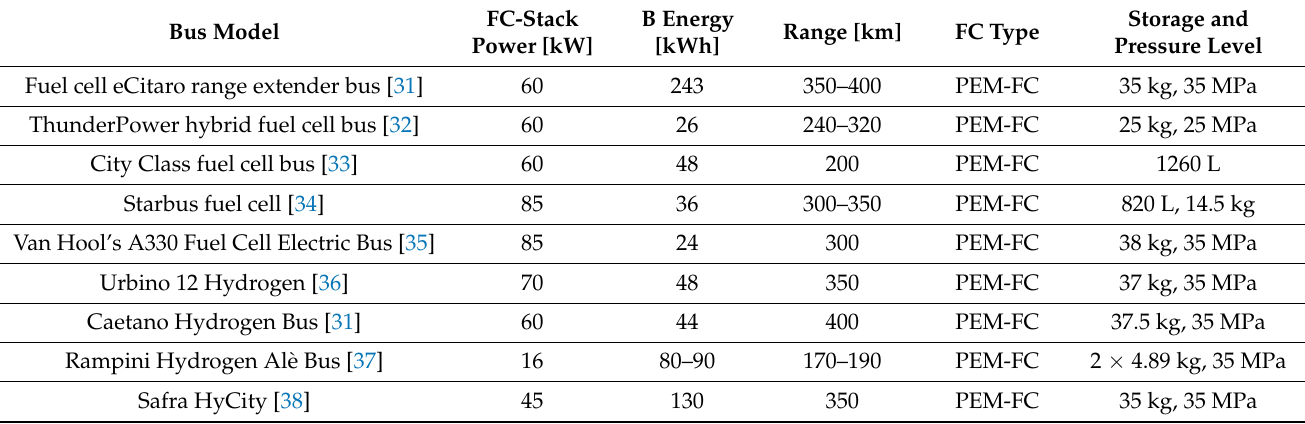
Table 2. Main characteristics of fuel cell Buses.